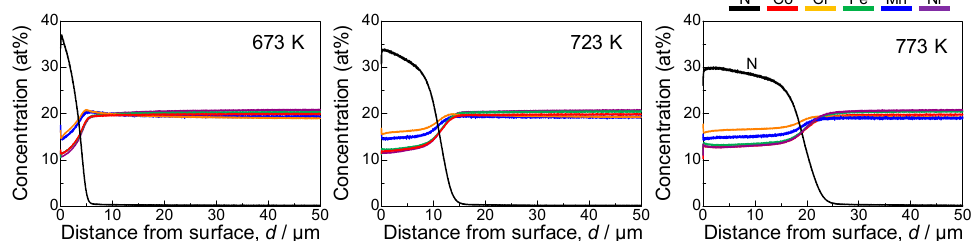
Figure 9. Glow-discharge optical-emission spectroscopy (GD-OES) profiles of the N, Co, Cr, Fe, Mn, and Ni concentrations for plasma-nitrided CoCrFeMnNi samples.